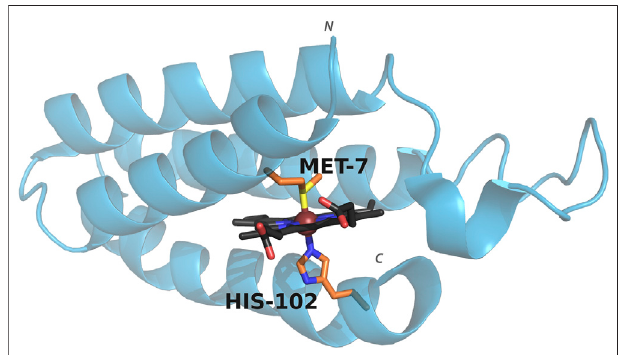
FIGURE 1 | Structure of cyt b 562 showing the coordinating axial ligands. PDB entry: 1QPU. Colors represent carbon (porphyrin: black, axial residues: orange),oxygen(red),nitrogen(blue),sulfur(yellow).Themetalionisshownas a sphere (brown). The N and C terminus are